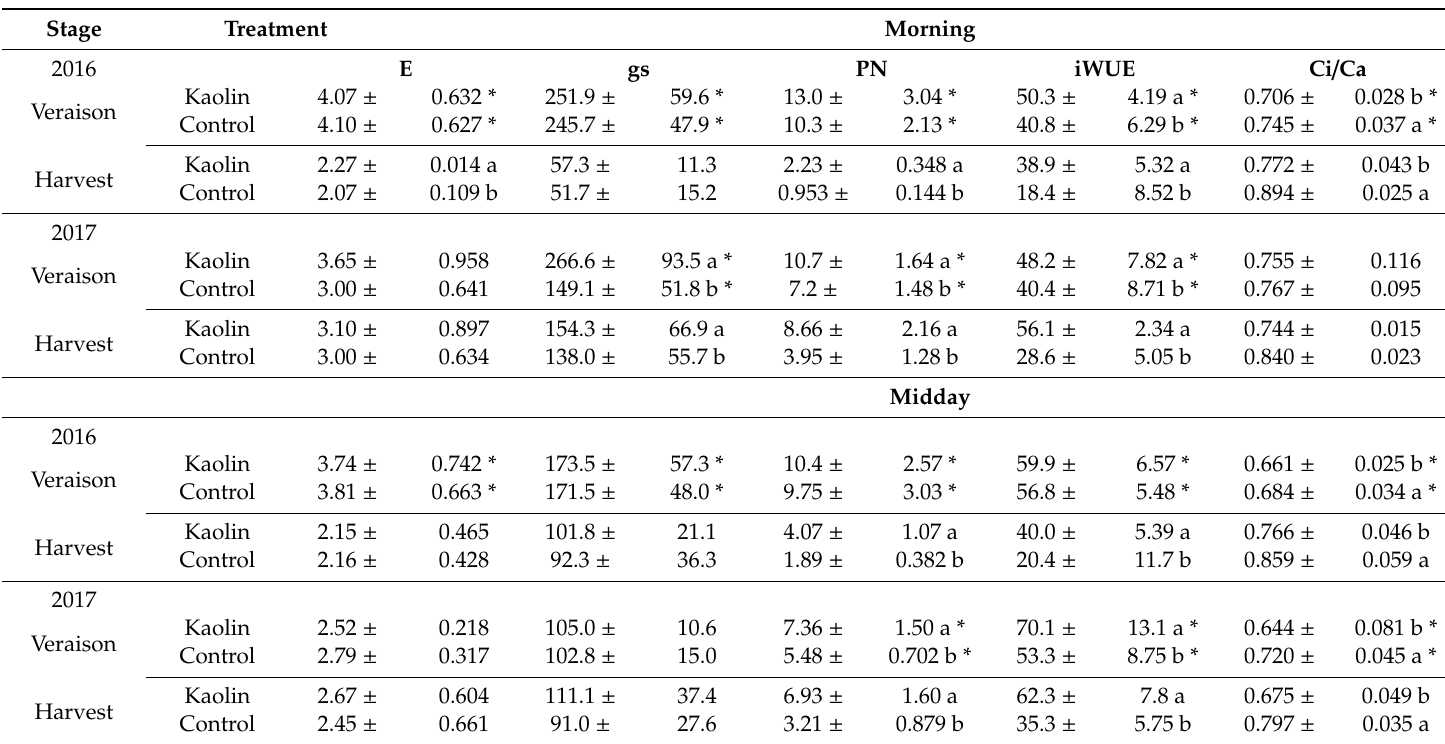
Table 1. Gas exchange parameters, namely transpiration rate (E, mmol m − 2 s − 1 ), stomatal conductance ( g s , mmol m − 2 s − 1 ), photosynthesis net ( P N, µ mol m − 2 s − 1 ), intrinsic water use e ffi ciency (iWUE, µ mol mol − 1 ), and ratio of intercellular to atmospheric CO 2 concentration (C i / C a ), at morning and midday periods in veraison and maturation stages in kaolin and control leaves ( n = 10). Di ff erent lowercase letters represent significant di ff erences between treatments (control vs. kaolin), in the same period of the day (morning / midday) and stage of the season (veraison / maturation). * represents significant di ff erences between stages of the season within the same period of the day ( p < 0.05). Absence of superscript indicates no significant di ff